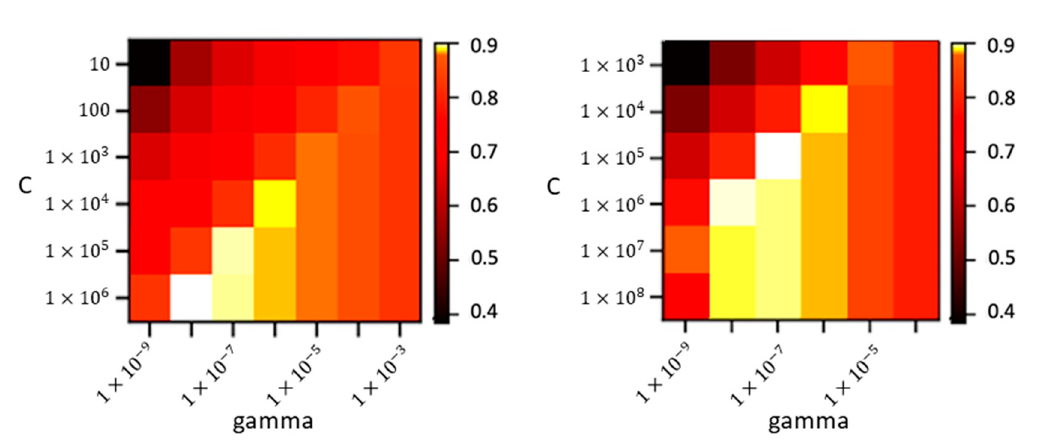
Figure 5. Heat map of the search space in the grid search. Left: Highest accuracy at the edge of the search space. Right: Adjusted search space .